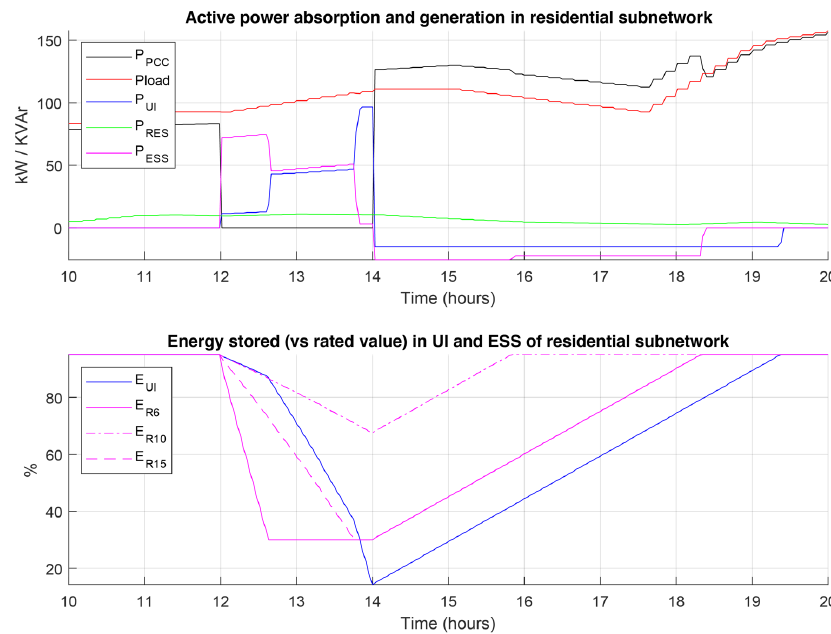
Figure 11. Integrating local and central control to implement islanded operation in residential sub- grid. tial